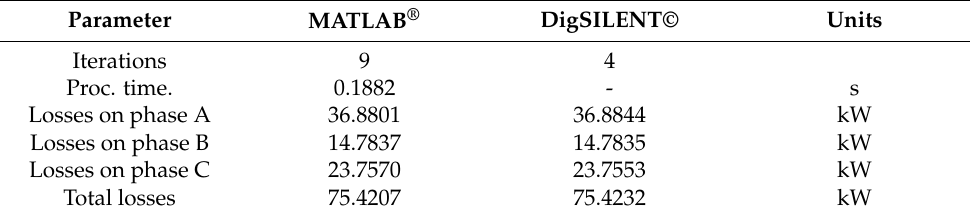
Table 7. Numerical results for the 25-node test